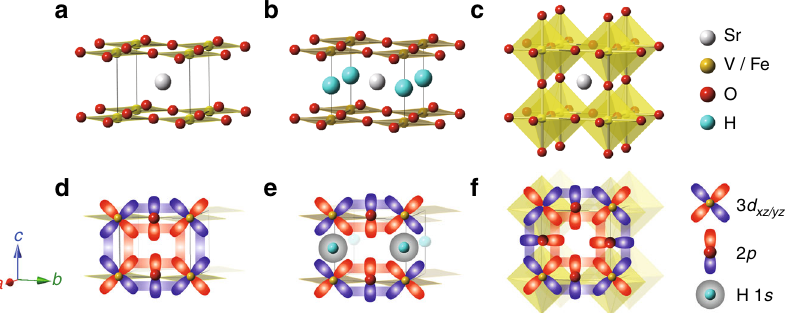
Fig. 1 Crystal structures of perovskite related materials. a SrFeO 2 , b SrVO 2 H, and c SrVO 3 . White, yellow, red, and sky blue spheres, respectively, denote Sr, transition metal, O and H atoms. d – f represent the inter- and intra-layer orbital